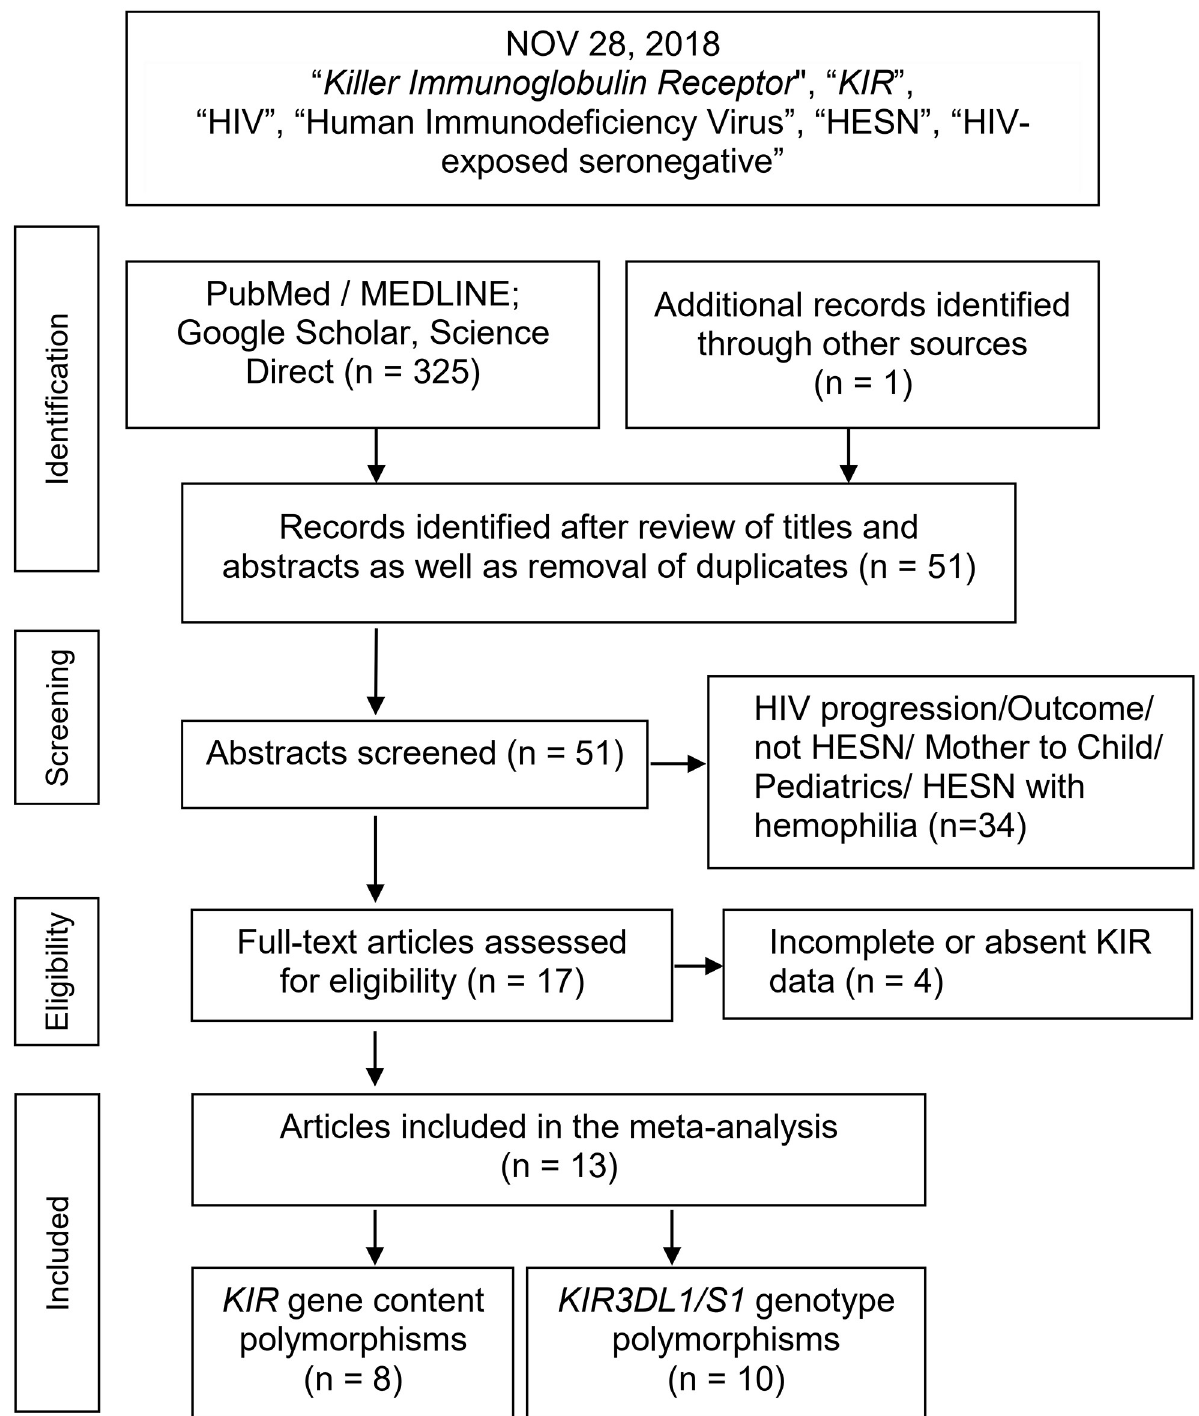
Fig 1. Summary flowchart of literature